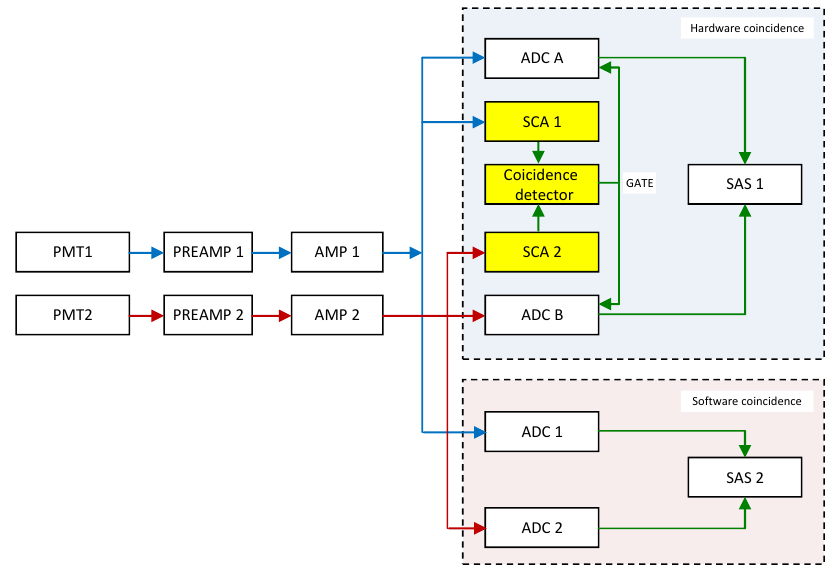
Figure 13. Schematic set-up for the hardware coincidence and software coincidence results comparison. The same analogue signals detected by PMT1 and PMT2 are introduced into both hardware coincidence and software coincidence chains. Working in hardware coincidence, SAS 1 only stores data from both chains. Working in software coincidence, SAS 2 detects coincidence and stores data. We can see in yellow the unnecessary modules when SAS is working in software coincidence.